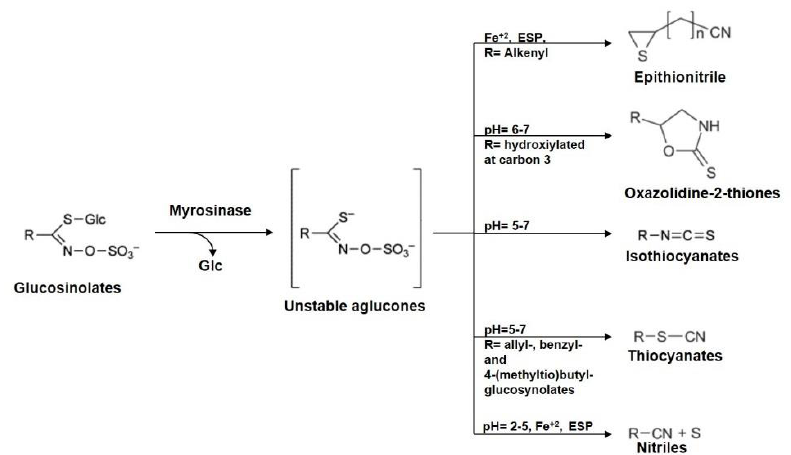
Figure 3. Simplified representation of glucosinolates (GLs) and their hydrolysis products. Myrosinase acts on GLs to form an unstable aglycone intermediate. It can rearrange spontaneously generating an isothiocyanate at neutral pH. Under certain conditions, such as in the presence of nitrile specifier proteins (NSPs), ferrous ions, or at pH < 5, GL hydrolysis is responsible for the formation of the corresponding nitriles. Instead, in the presence of epithiospecifier proteins (ESPs), GL hydrolysis gives epithionitriles from alkenyl GLs through a ferrous ion-dependent mechanism.